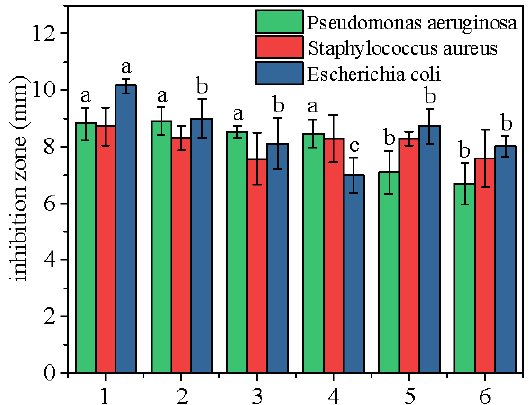
Figure 4. Antibacterial activity of Bletilla striata flowers. Note: Different alphabets indicate statistical differences between groups, and the same alphabets indicate no statistical differences between groups.